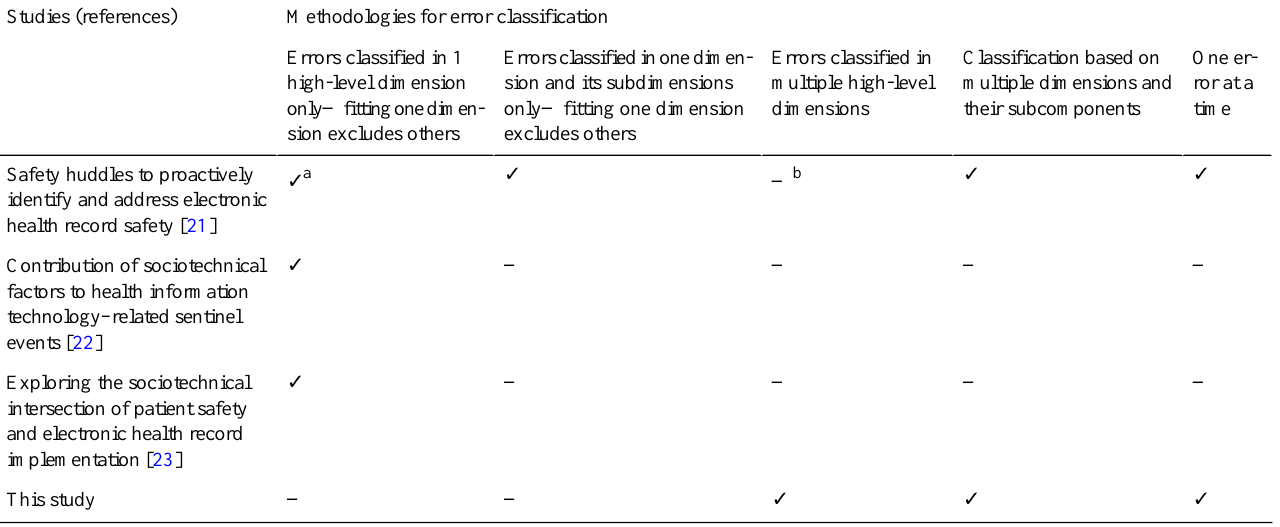
Table 1. A comparison with previous studies based on the use of the sociotechnical framework Methodologies for error classificationStudies